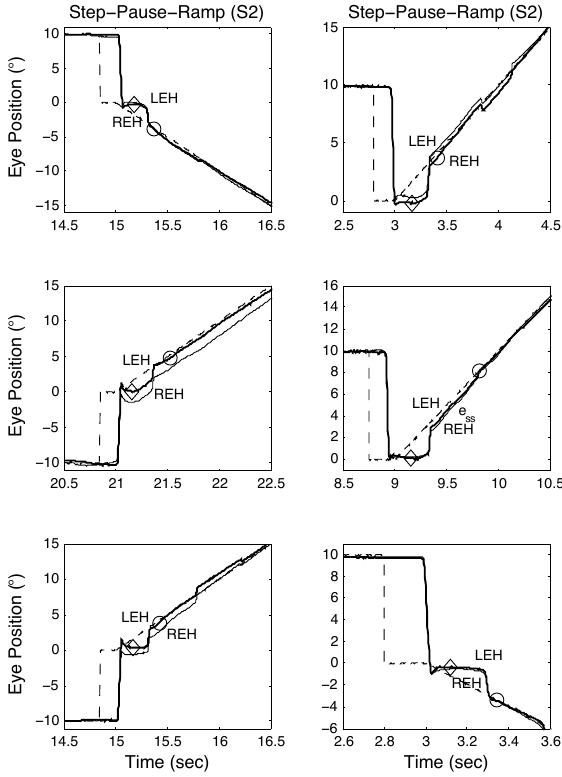
Figure 7. Examples of SPR responses from S2 containing proximal saccades demonstrating both classical and other types of response, including those containing disconjugate saccades. See text for